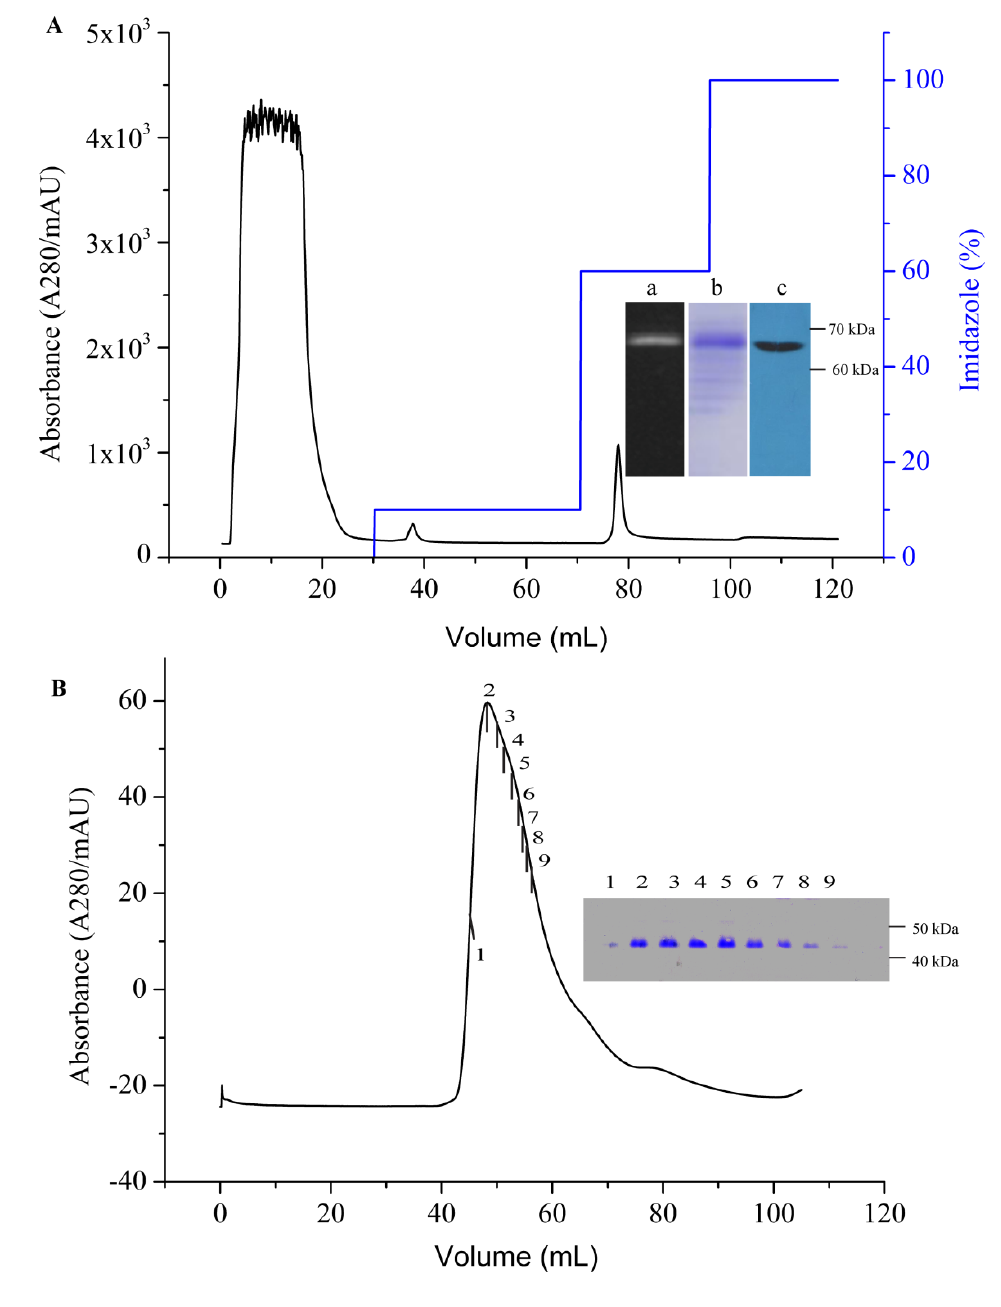
Figure 5. Protein purification. ( A ) Preliminary purification of AgrC-GFP by immobilized metal affinity chromatography (IMAC). The fraction that was eluted from the IMAC column (packed with 5 mL of HisTrap HP) with 60% elution buffer using an ÄKTA express system was analyzed by SDS-PAGE. ( a ) In-gel GFP fluorescence image; ( b ) staining of the same part of the gel with Coomassie brilliant blue; and ( c ) immunoblotting of the same part of the gel with anti-His-HRP; ( B ) Superdex200 SEC profiles. Following TEV digestion and batch IMAC purification, the sample was subjected to SEC and an SDS-PAGE analysis of the SEC peak is shown in the inset. The numbers 1–9 corresponding to the fractions on the chromatogram. The molecular weight was calculated to be ~47 kDa, which matched the theoretical molecular weight of native